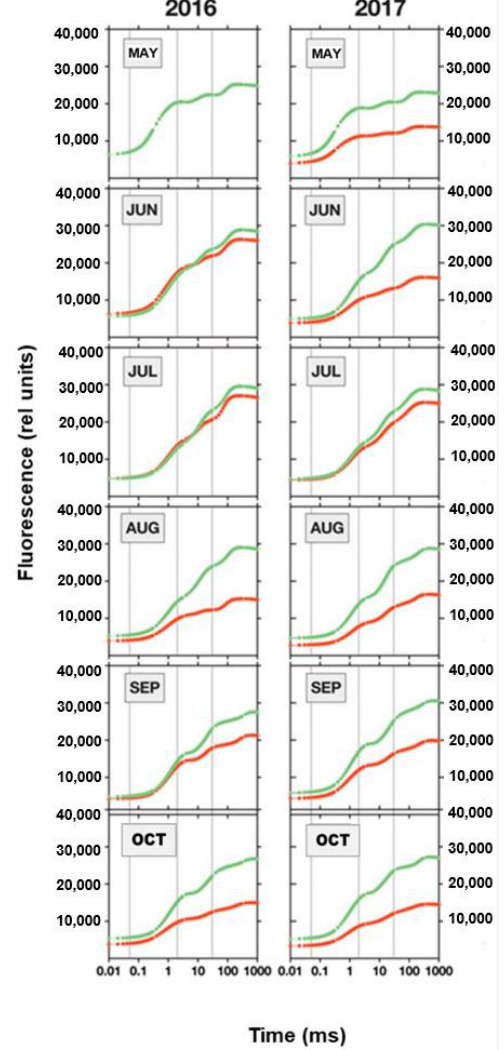
Figure 3. Fluorescence kinetics of PS II chlorophyll fluorescence, comparison of OPM-infested leaves of oaks (red curves) with leaves of non-infested ones (green curves) at Gollenberg, Rhinow, Brandenburg. May to October 2016 and 2017.